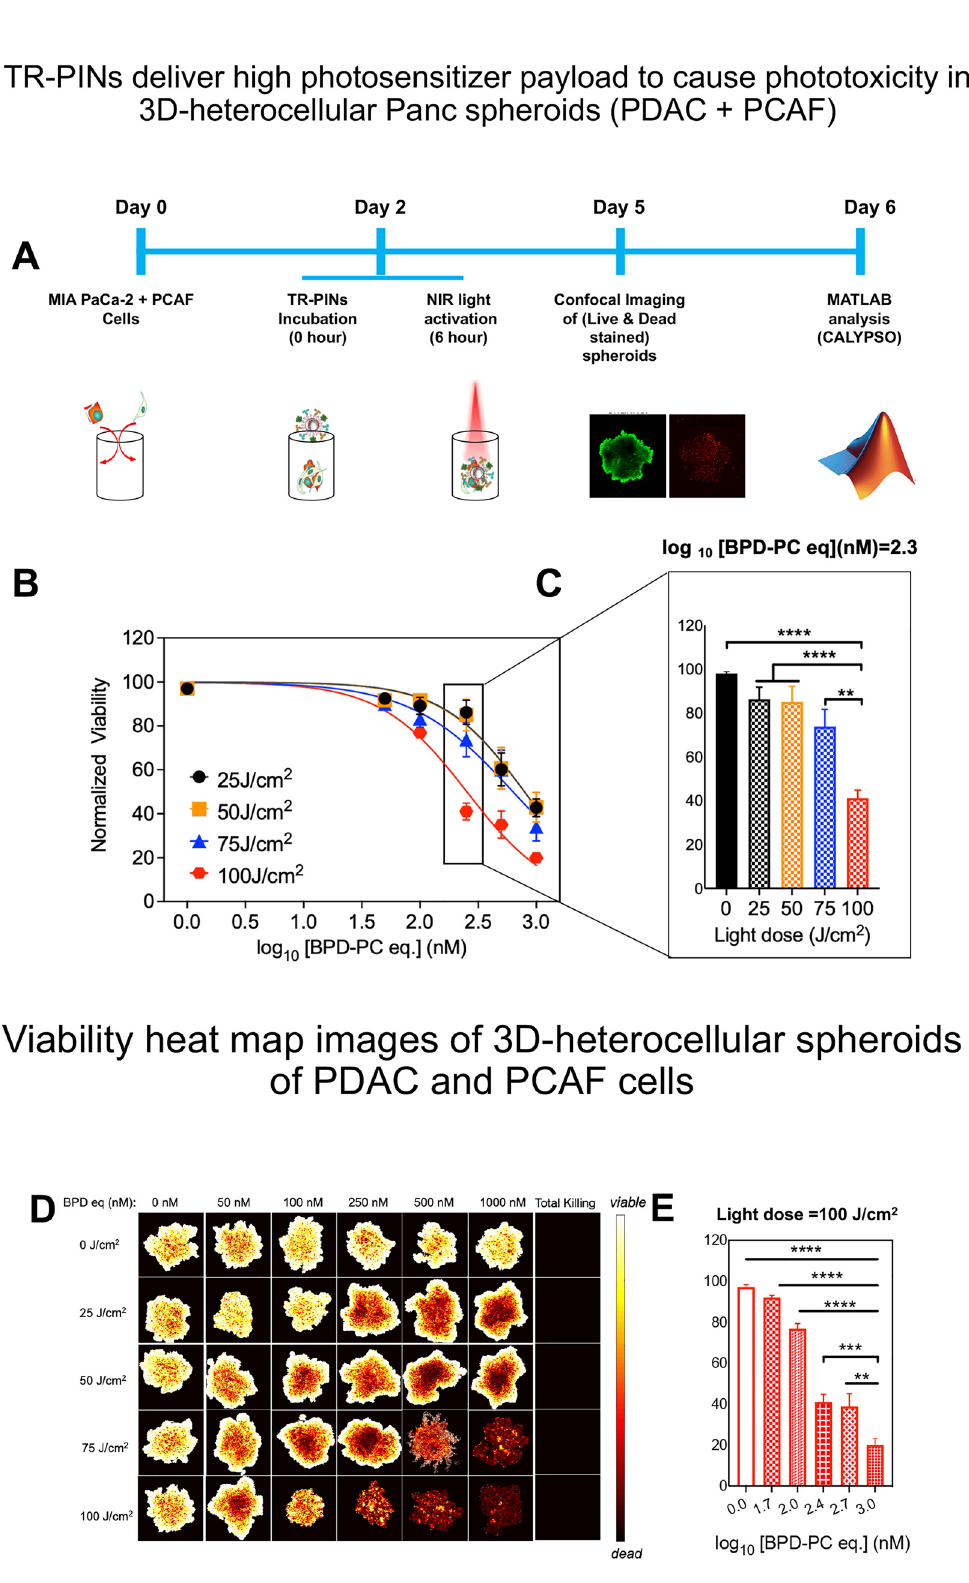
Figure 3: Schematic representation of the culturing and treatment of heterocellular Panc (PDAC-PCAF) spheroids followed by an imaging- based analysis of treatment response. Acomprehensiveimageanalysisprocedureforstructurallycomplexorganotypiccultureswasusedforthequantitationoffractionalviabilityof spheroidsfollowingNIR photodynamic activation (A) usingTR-PINs andPSNs (B). The NIR photodynamicactivation regimenused was 690